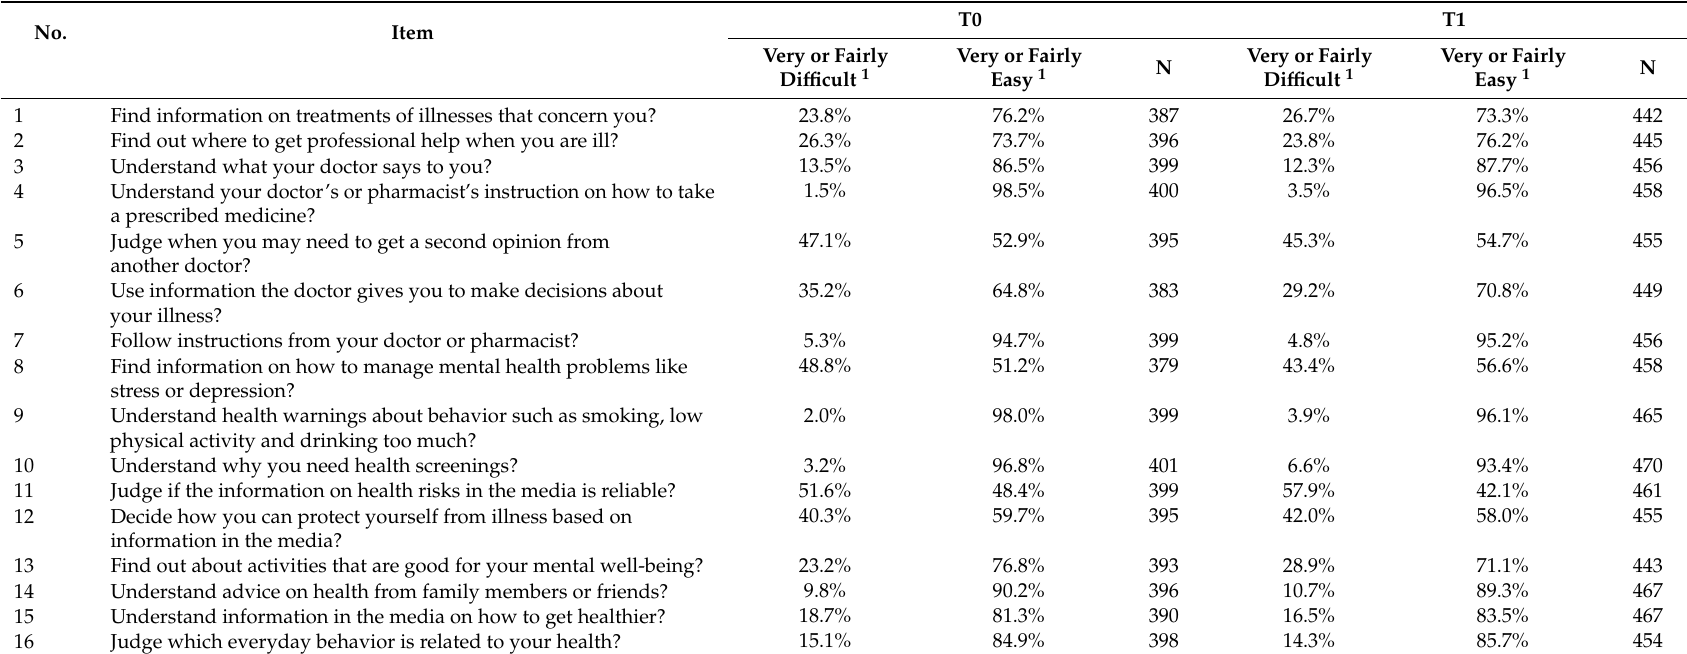
Table 6. HLS-EU-Q16 Health Literacy Matrix Items (teachers, T0 and